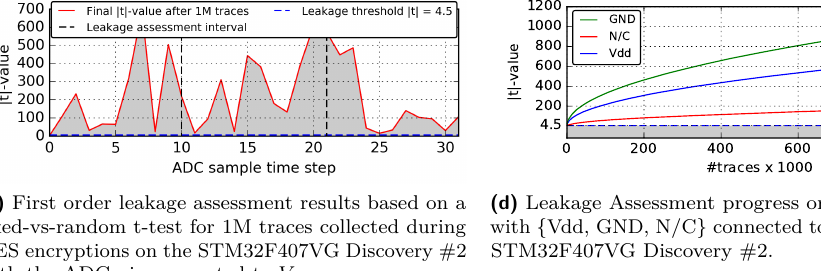
Figure 17: Results of Leakage Assessments on STM32F407VG Discovery #2 for mbedTLS AES.